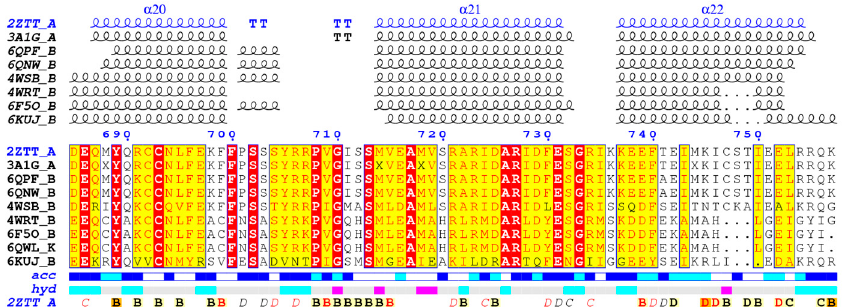
Figure 3. Comparison of the results of A-chain sequences of 2ZTT.